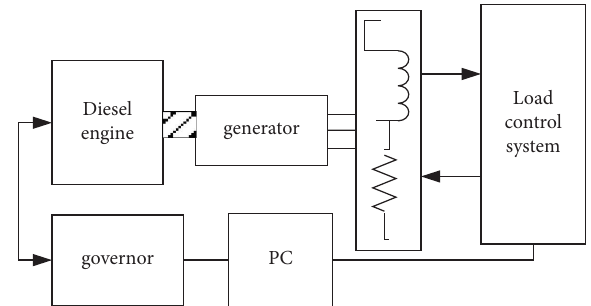
Figure 13: Diagram of the diesel engine speed control